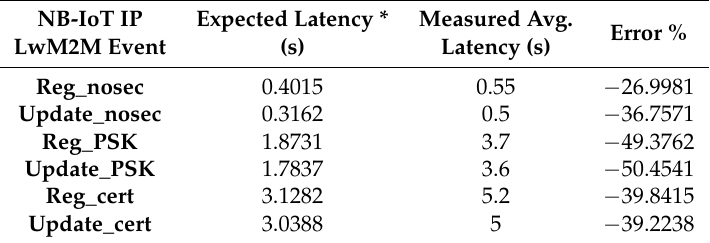
Table 2. Table for NB-IoT latency for different LwM2M events.